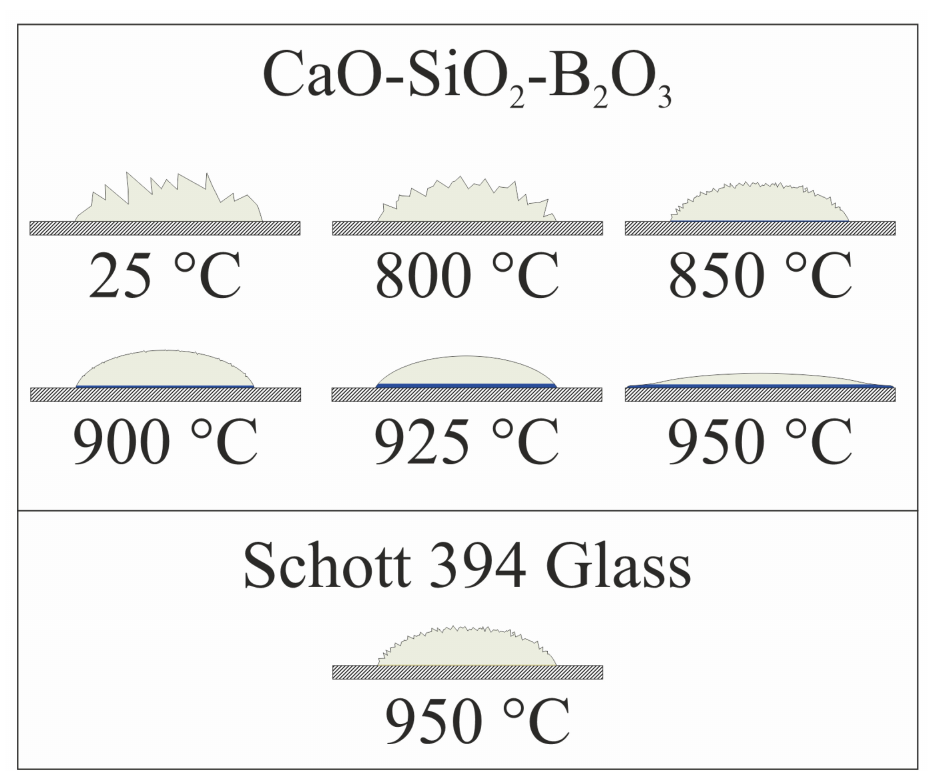
Figure 3. Shape and color of sealants after heat treatment for 1 h. For CaO-SiO 2 -B 2 O 3 sealant, heat treatment at 800 ◦ C for 1 h did not cause any notable change in the geometry of the powder pile. Sharp edges of the particles remained and the particles themselves were only loosely bound to each other. We observed no reaction zone on sealant/steel interface. Increase in the temperature to 850 ◦ C led to some softening of the angles of the powder pile and to the formation of a thin (~ 100 um), but notable layer of dark blue color at the interface with steel. Even further increase in temperature led to progressive softening of the relief of the pile and thickening of the blue layer to ~300 µ m at 925 ◦ C. At this temperature, surface of the sealant became smooth, forming a drop, slightly wetting the steel plate. It indicates that the glass softening point lies between 850 ◦ C and 925 ◦ C. For samples heated to 950 ◦ C, we observed spreading of the sealant over the surface of the plate, demonstrating excellent wetting and low viscosity of the sealant. The latter is undesirable for sealing of SOFCs because low-viscosity sealant may flow from the designed areas and block air or fuel channels. In the following discussions, part of the sealant that was not in direct contact with the steel plate and did not change color significantly is named “White area”. The part that was in contact with the plate and changed its color to saturated blue is named “Blue area”. The key difference between these regions is that the former represents change in the sealant itself after the heat treatment, while the latter represents products of interaction of the sealant and Crofer plate. Experiments with Schott 394 glass were conducted only for 950 ◦ C because it is a recommended sealing